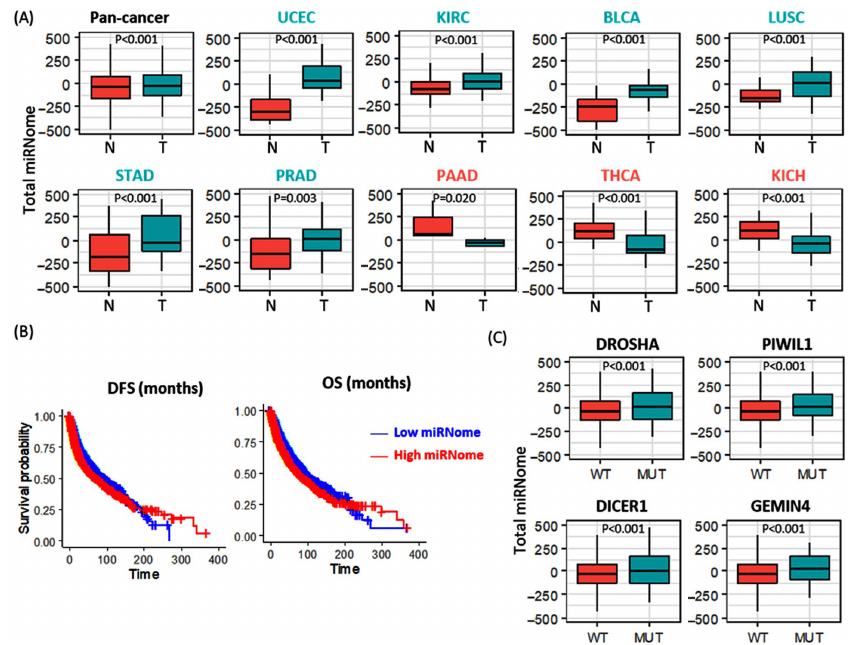
Figure 8. Differential expression of total microRNome level in cancer. Genes with significant results are only shown. ( A ) Total microRNome levels in paired tumor (T) and normal (N) samples. Overall and stratified analyses were performed. Y axis represents the average z score for all mature miRNAs per the study. Across the pan-cancer subtypes, 9 out of 33 cancers showed significant results. BLCA (bladder urothelial carcinoma), KICH (kidney chromophobe carcinoma), KIRC (kidney clear cell carcinoma), LGG (lower grade glioma), LUSC (lung squamous cell carcinoma), PAAD (pancreatic ductal adenocarcinoma), PRAD (prostate adenocarcinoma), STAD (stomach–gastric adenocarcinoma), THCA (thyroid papillary carcinoma), UCEC (uterine corpus endometroid carcinoma). ( B ) Kaplan– Meier curves for survival analysis show the association of the expression level of total micrRNome level with disease-free survival (DFS) and overall survival (OS) in pan-cancer. ( C ) Impact of gene mutation on the expression level of mature microRNAs. Y axis represents the average z score for all mature miRNAs. Comparisons between mutant (MUT) and wild-type samples (WT) are shown. The Mann–Whitney U test was used to test the